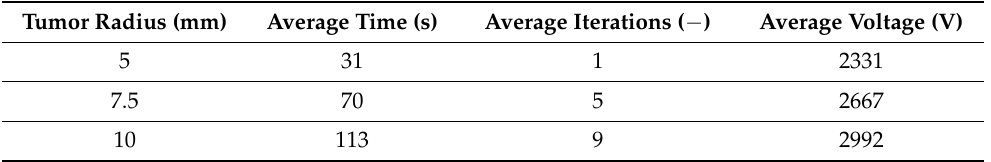
Table 3. Tumor radius is the only variable affecting the algorithm’s performance. The average computation time, iterations, and applied voltage are shown for each modelled tumor